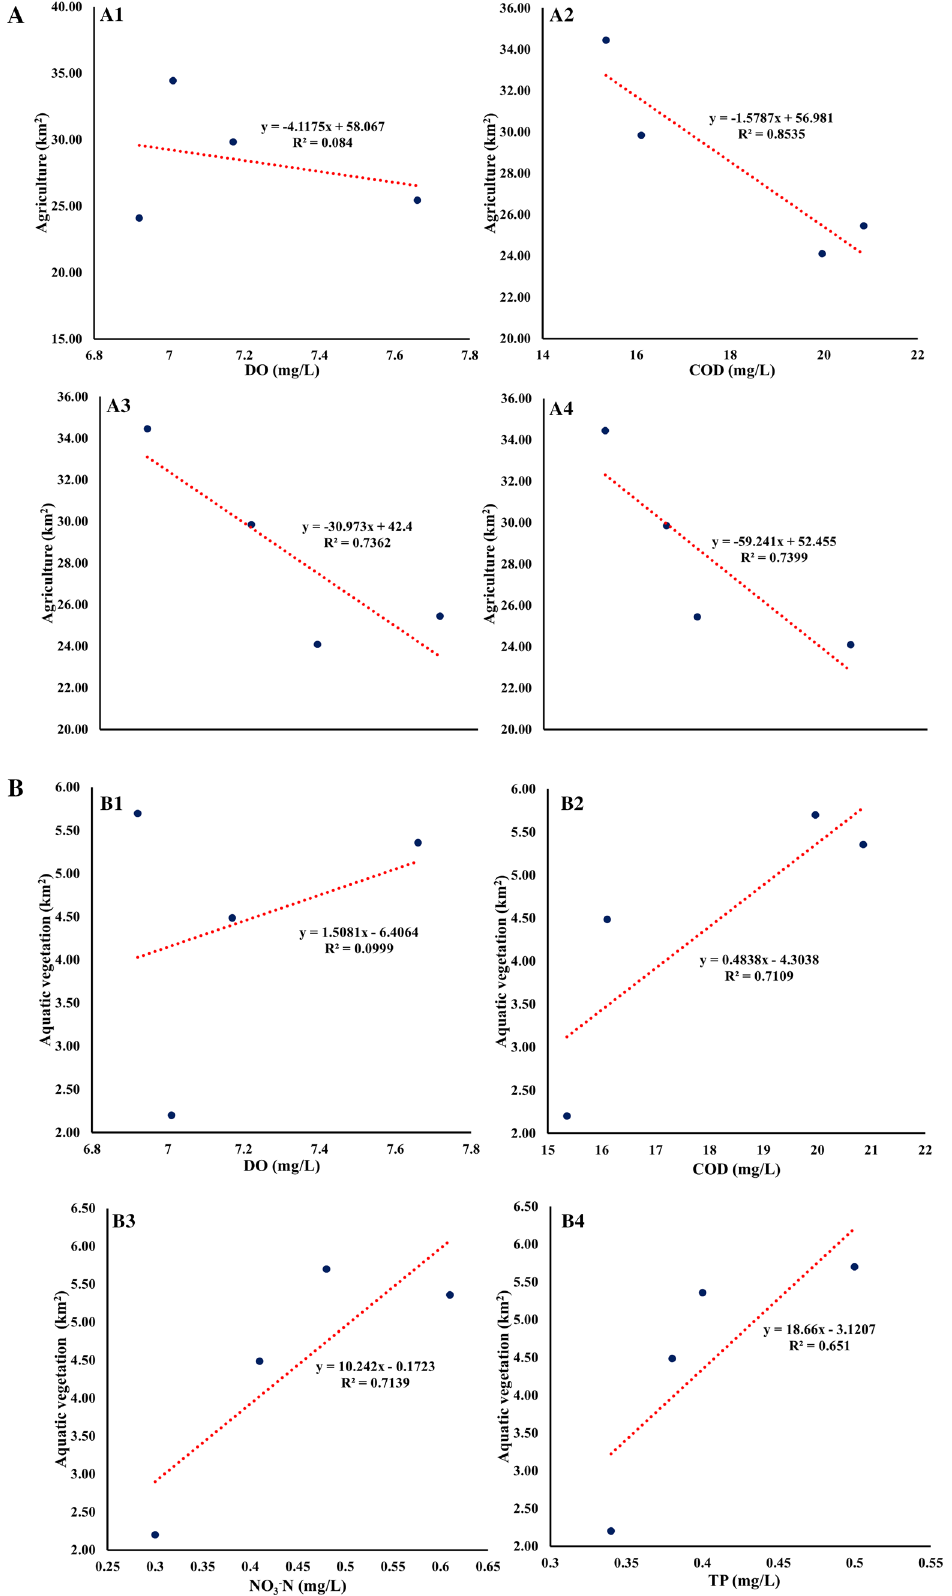
Fig. 10 a – e Scatterplots of area of LULC classes of the Dal Lake catchment versus WQ parameters of the